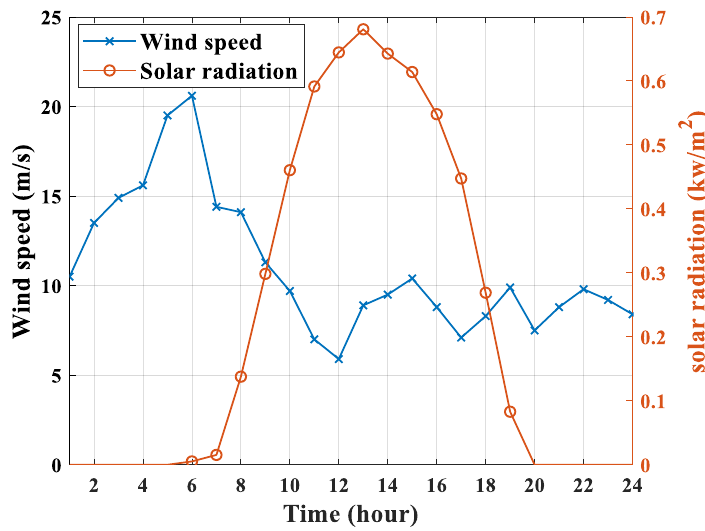
Figure 4. Wind speed and solar radiation. Table 1. Parameters of the proposed system.